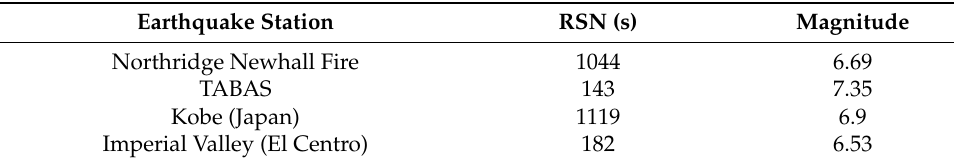
indicates the responses with only LRBPs (blue curve) and with LRBPs combined with the viscous dampers (orange curve), under the Northridge earthquake. It can be seen that the maximum relative displacement for the case of only LRBPs is 73 mm. However, with the proposed system (VD-LRBP), it is reduced to 30